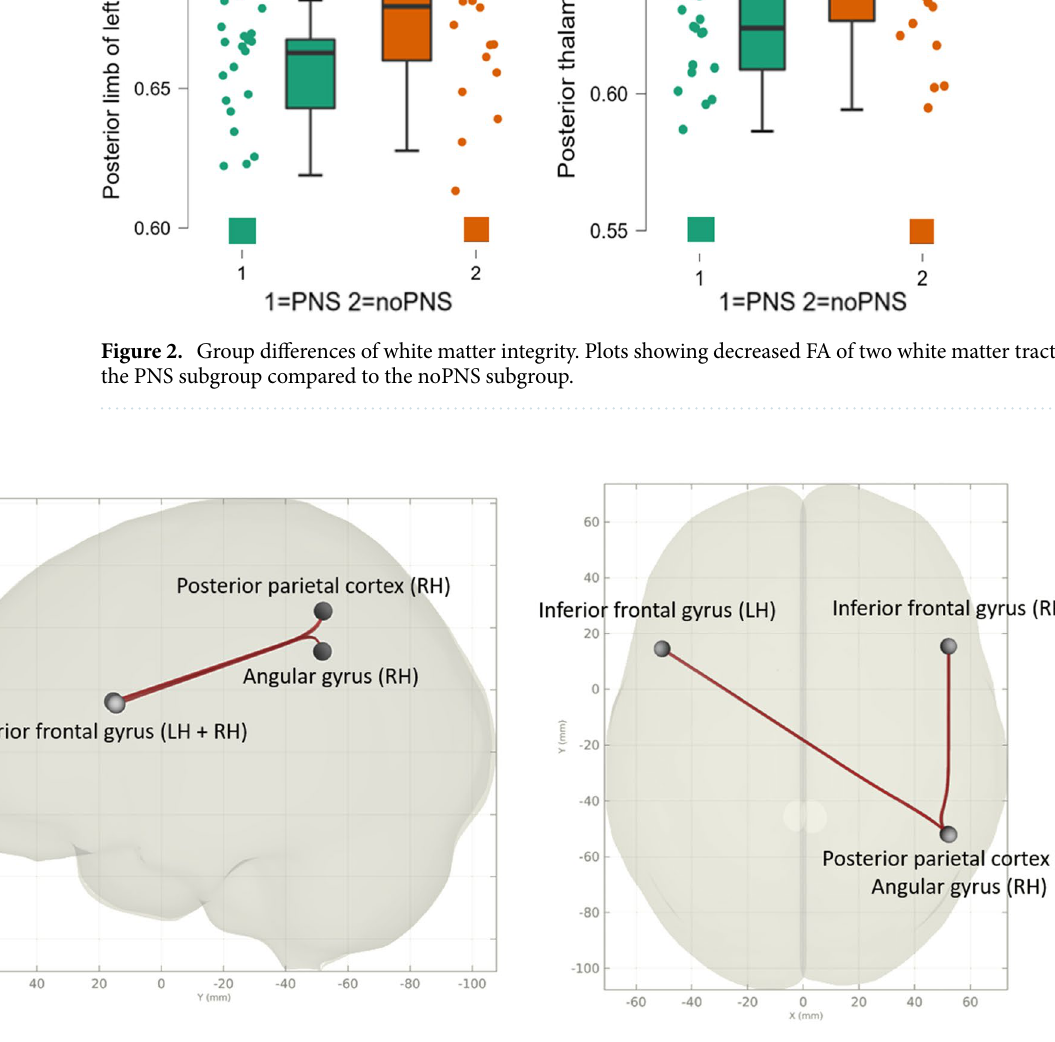
Figure 3. Group differences of functional seed-to-seed connectivity. Hyperconnectivity cluster in the PNS subgroup compared to the noPNS subgroup (LH: left hemisphere, RH: right